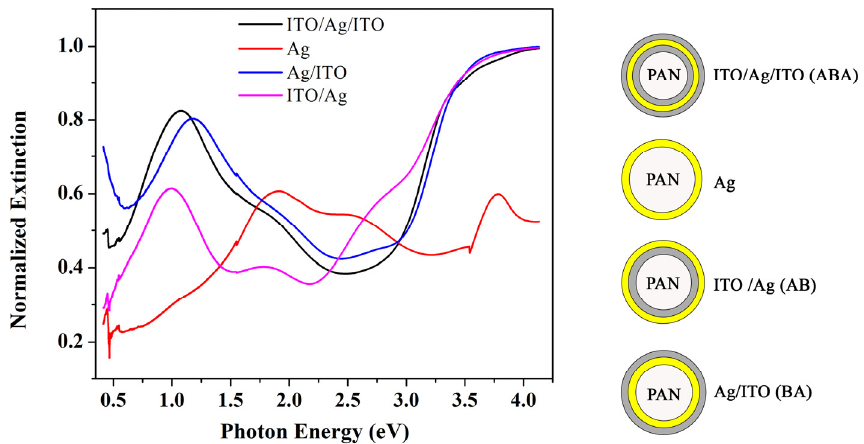
Figure 2. Extinction spectra of multilayer core shell nanostructured electrodes.